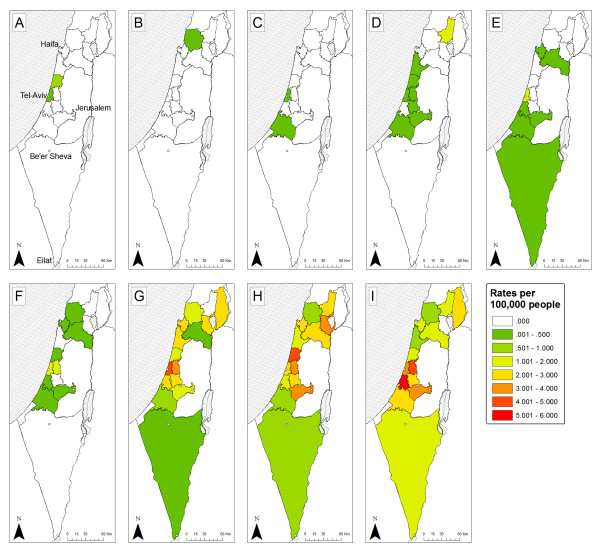
Spatial spread of swine flu in sub-districts of Israel. The data are combined for each week up to week ten of the epidemic (week three had no cases in it and therefore isn't displayed). The color of the region represents its rate of Influenza, from dark green - low rate (up to 0.5 cases per 100,000 people) to red- high rate (5-6 cases per 100,000 people). The panes represent different weeks (A-first 26/4-2/5/2009, B-second 3-9/5/2009, C-fourth 17-23/5/2009, D-fifth 24-30/5/2009, E-sixth 31/5-6/6/2009, F-seventh 7-13/6/2009, G-eighth 14-20/6/2009, H-ninth 21-27/6/2009, I-tenth 28/6-4/7/2009). Also on the map five major cities of Israel are marked as dots; the cities are (from north to south): Haifa, Tel-Aviv, Jerusalem, Be'er-Sheva, Eilat.